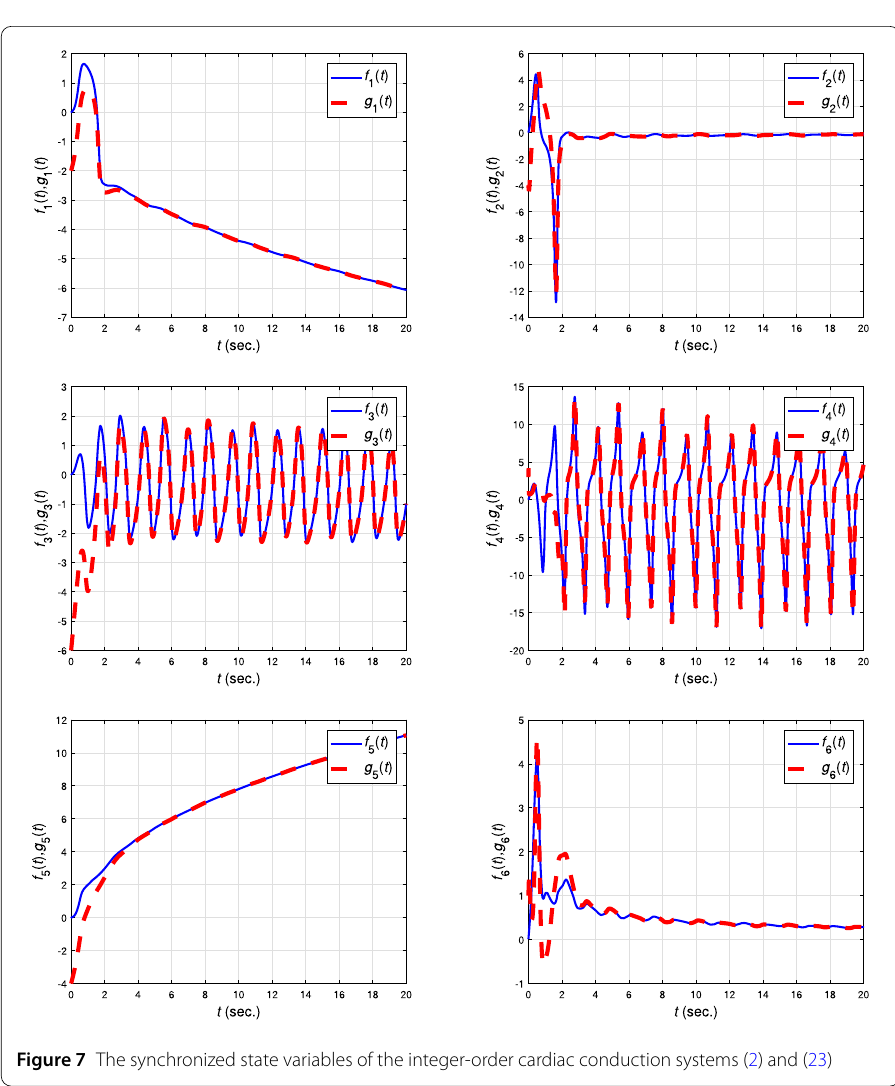
Figure 8 Synchronization error of the integer-order cardiac conduction systems (2) and